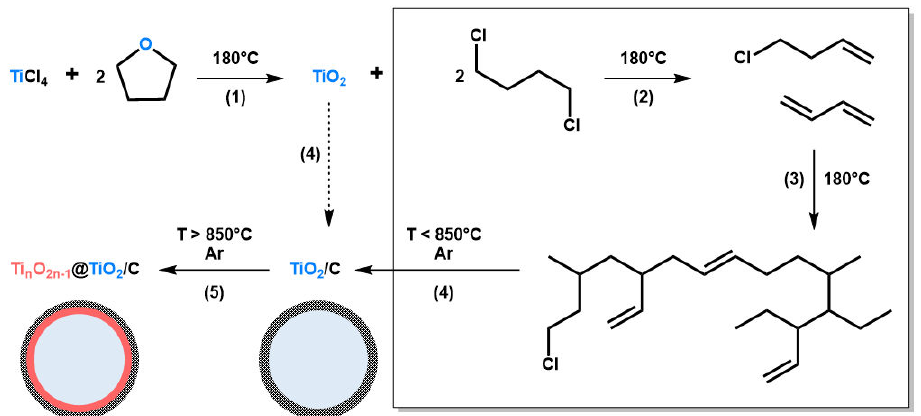
Figure 1. Schematic representation of the non-hydrolytic sol-gel (NHSG) route developed herein to prepare TiO 2 , TiO 2 / C and Ti n O 2 n − 1 @TiO 2 / C nanocomposites. (1) Alkoxylation / Condensation; (2) Dehydrochlorination; (3) Polymerization; (4) Carbonization; and (5) Partial carbothermal reduction. In this representation, xer-TiO 2 corresponds to TiO 2 together with organic by-products (box on the right side) before step